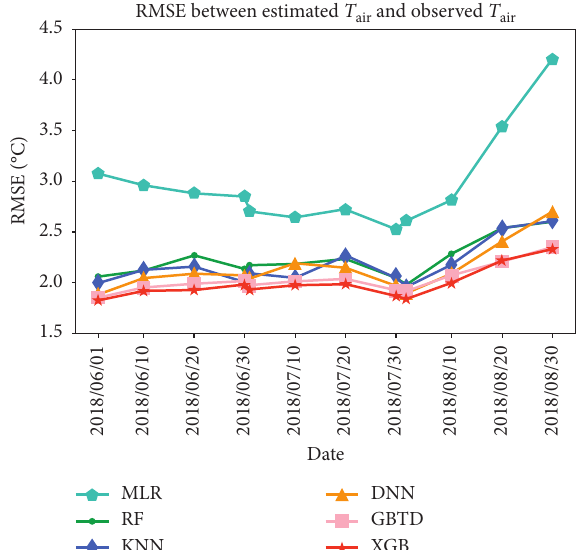
air for six machine-learning models. air estimation model. XGB model RMSE ( ° C) 3.003 ° C 2.376 ° C 2.164 °